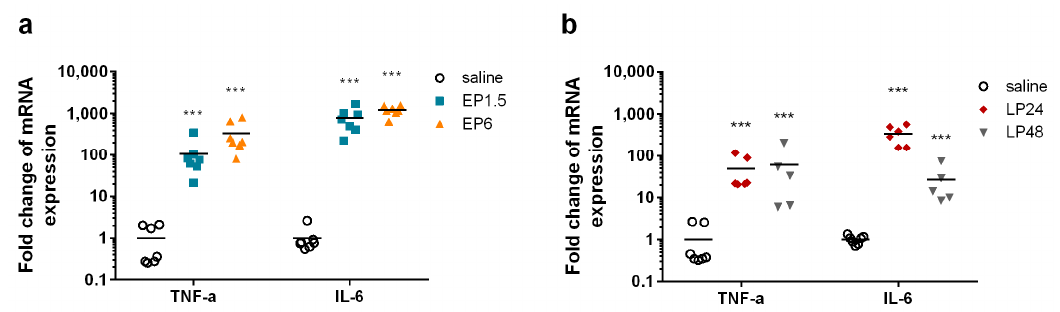
Figure 1. Fold changes of TNF- α and IL-6 mRNA relative to the saline-treated control kidneys in mice after lipopolysaccharide (LPS) administration. ***: p ≤ 0.001. ( a ) early phase (EP)1.5 and EP6 groups. ( b ) LP24 and LP48 groups.